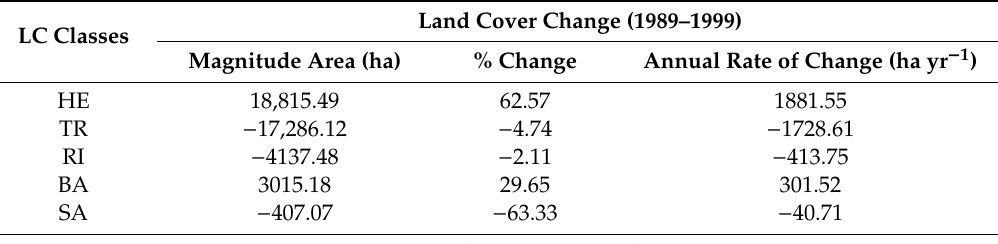
Table 3. LC change assessment of the SRF based on di ff erent time frame data (1989 to